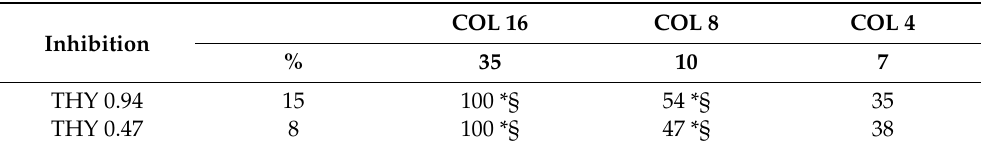
Table 3. Percentage inhibition of the four ETEC strains resistant to tetracycline in the presence of combinations of tetracycline (TET, mg/L) and thymol (THY, mM). TET 64 TET 32 TET 16 Inhibition % 53 35 28 THY 0.94 47 95 *§ 77 *§ 61 * THY 0.47 32 61 47 39